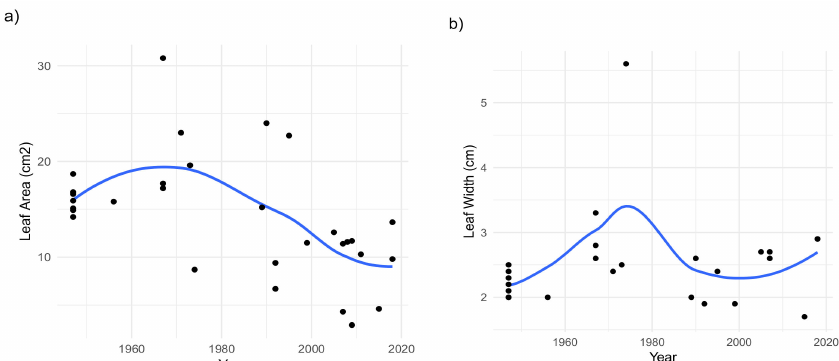
Figure2. Generalizedadditivemodelsfor( a )changesinleafareain S.carpetanus fromthehigh-mountain habitats of Sierra de Guadarrama in the last 72 years; ( b ) leaf width variations in conserved specimens of S. carpetanus over the last 72 years. The blue lines correspond to the modeled data; the gray area represents the “smoothed” parameter estimation, in accordance to the generalized additive models